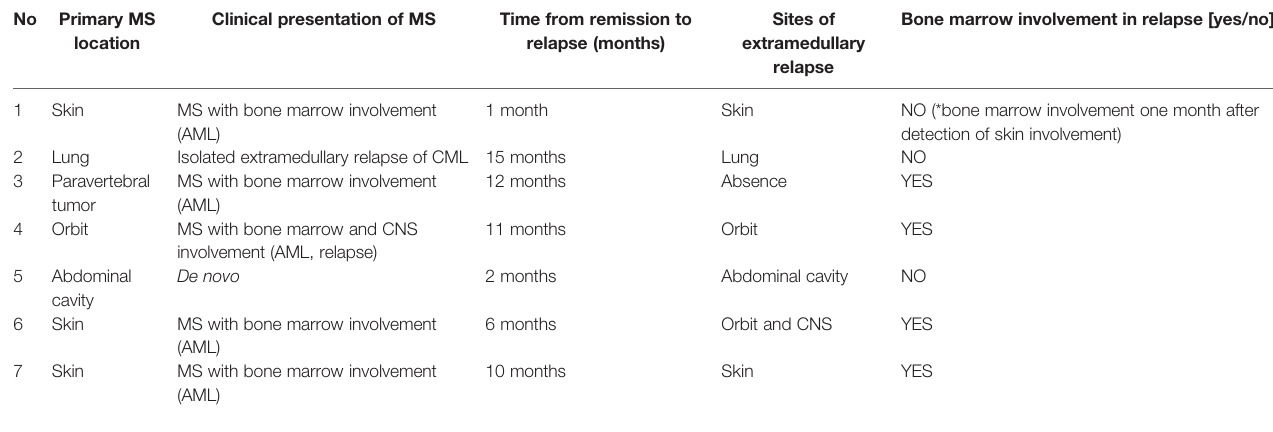
TABLE 4 | Characteristics of MS